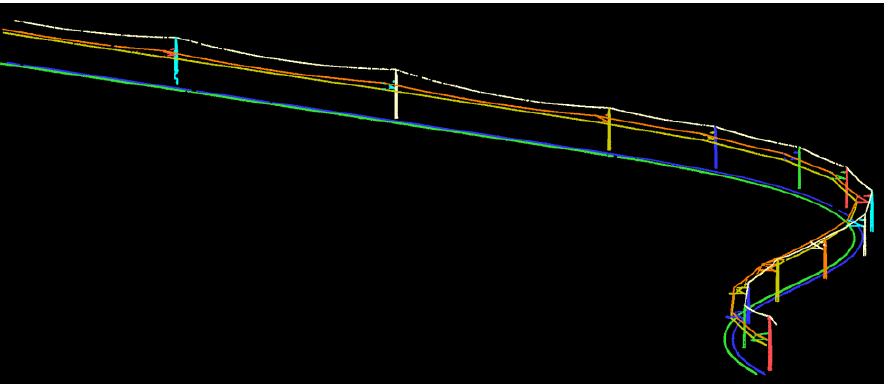
Figure 16. Recognized railroad key components (regardless of their types) are visualized by different